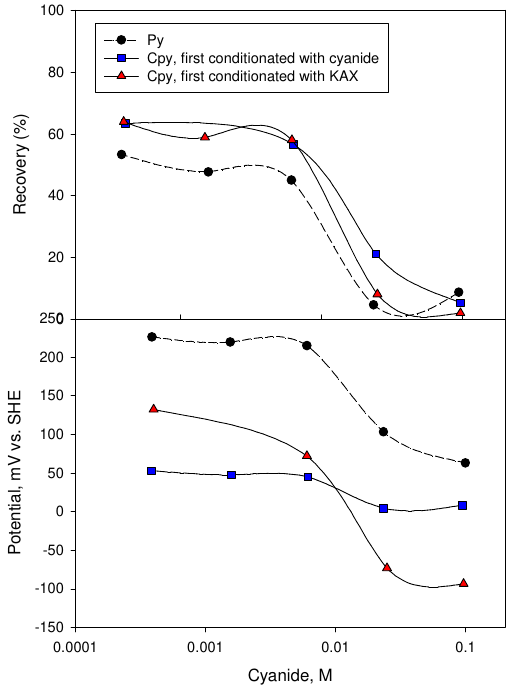
Figure 34. Recovery and flotation potential of pyrite and chalcopyrite through cyanide as a depressant. Conditions: potassium amyl xanthate (KAX), nitrogen use for airflow (adapted from Kocabağ et al. [145]).